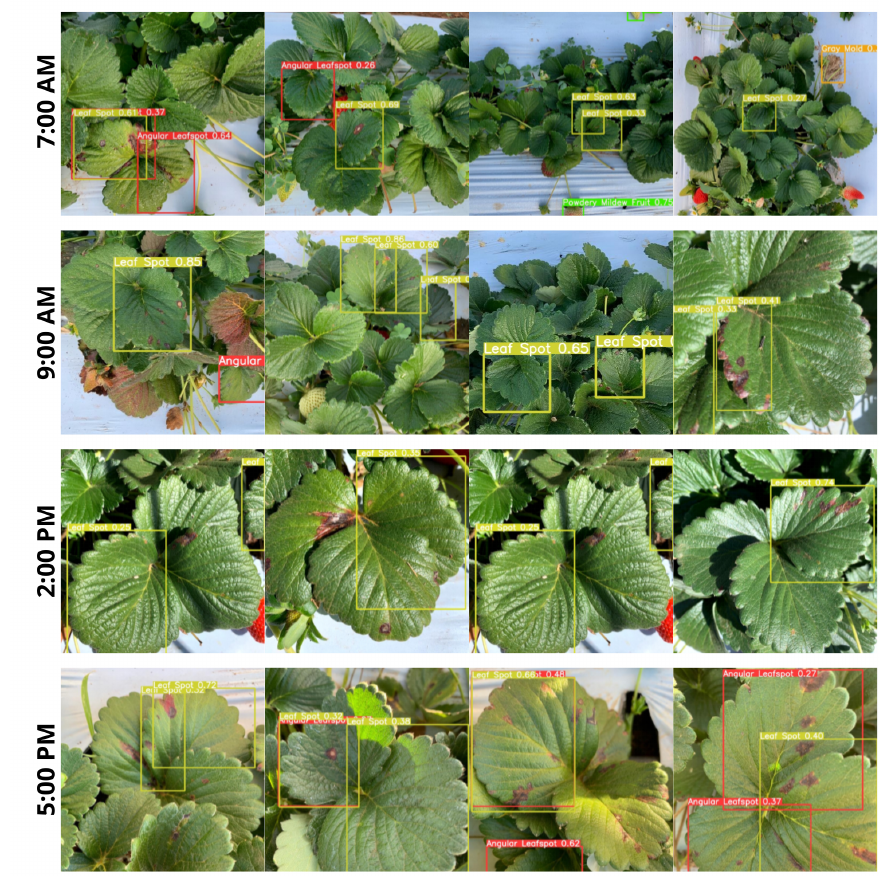
Figure 27. Detections performed by the model on images captured in the